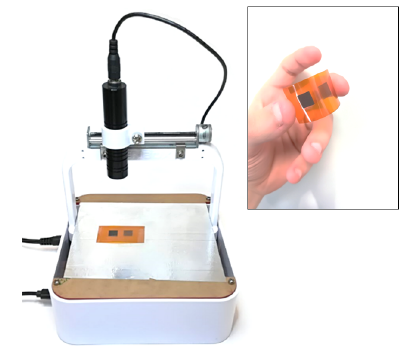
Figure 1. Experimental setup for the laser irradiation of the polyimide surface. The inset displays a sample with two patterned areas of 1 cm 2 on the surface scribed at two different values of the laser power: 50 mW (lighter one) and 100 mW (darker